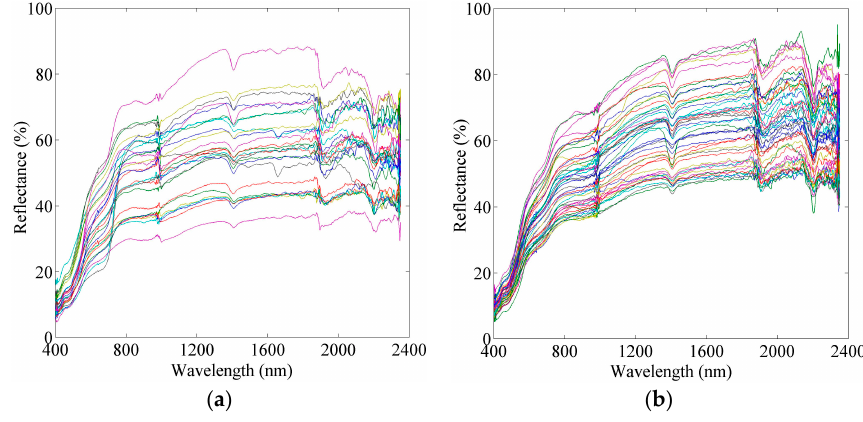
Figure 6. Result of soil reflectance spectra classification with K-means clustering based on Cosine of spectral angle: ( a ) Group C1; and ( b ) Group C2.